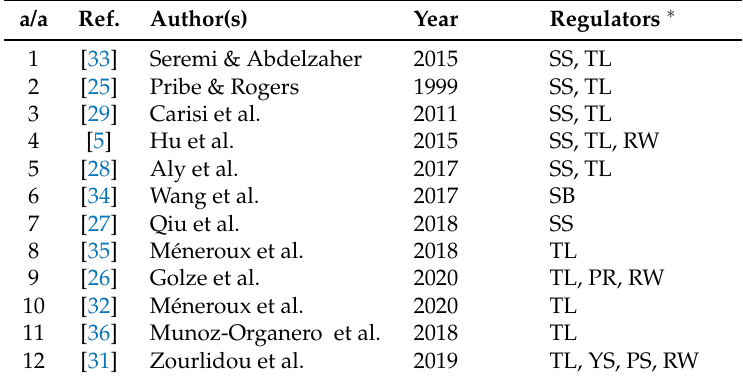
Table 1. Studies that detect traffic regulators from crowdsourced